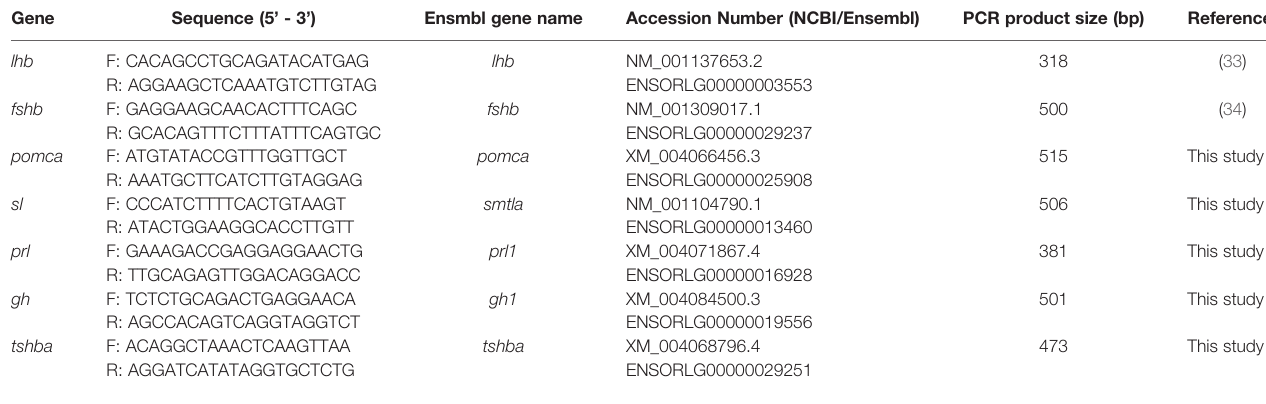
TABLE 2 | Primer sequences used to make the in situ hybridization (ISH) probes of seven endocrine cell types in the medaka